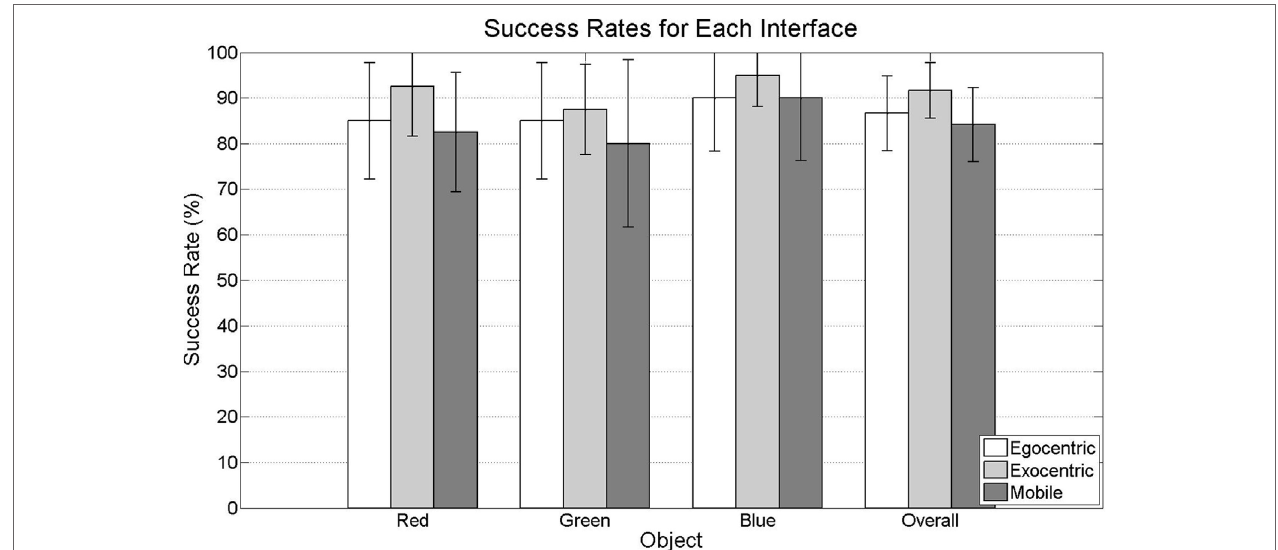
FigUre 10 | rates of successful pick and place operations accomplished using each interface .